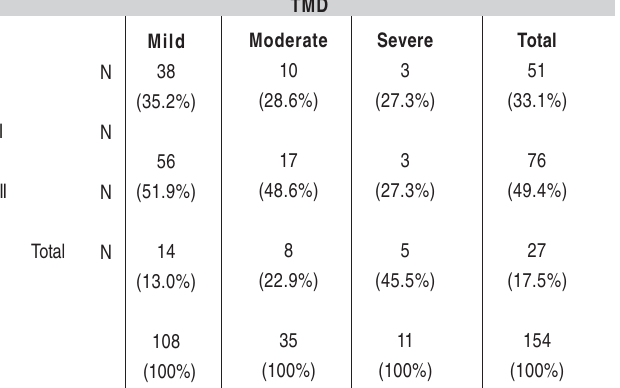
Table 5 . Significance between the means for cervical angles in the different occlusal classes.